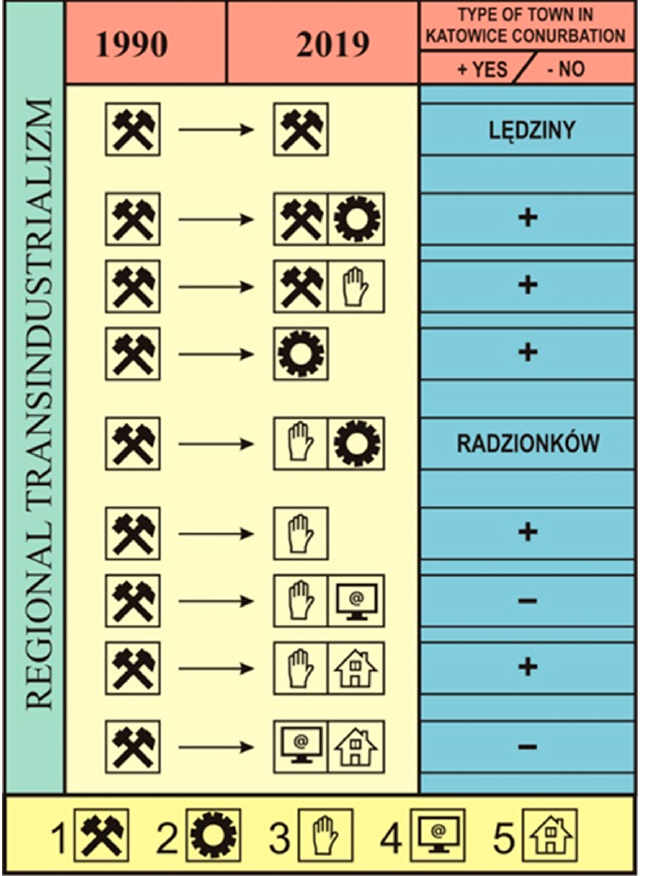
Figure 2. Models of economic transformation of the Katowice conurbation’s towns as the core of the transindustrialism phenomenon (illustration sourced by authors). Explanations: 1—coal-mining; 2—industry; 3—service; 4—business process outsourcing (BPO), shared services centers (SSCs), research and development (R&D), and industry 4.0; and 5—residential functions.